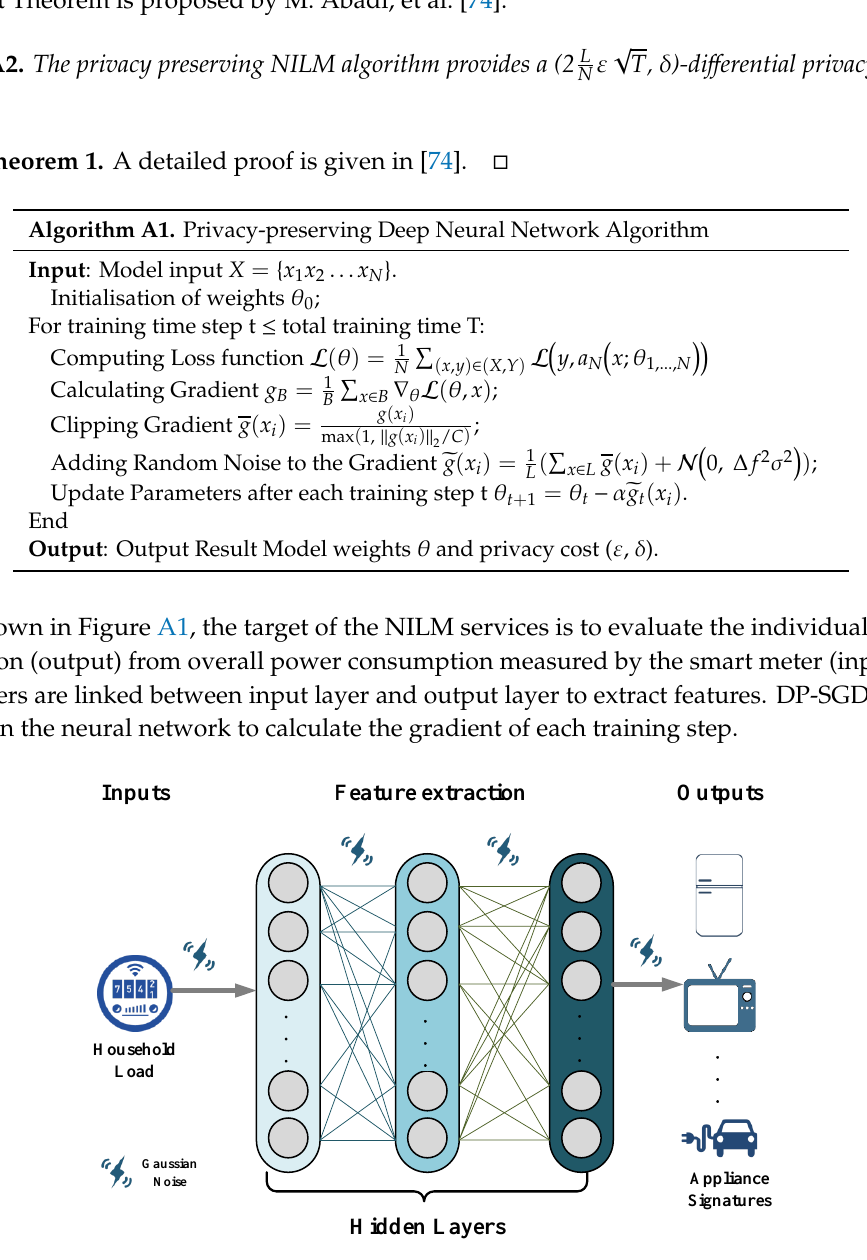
Figure A1. Privacy-preserving deep learning NILM model .